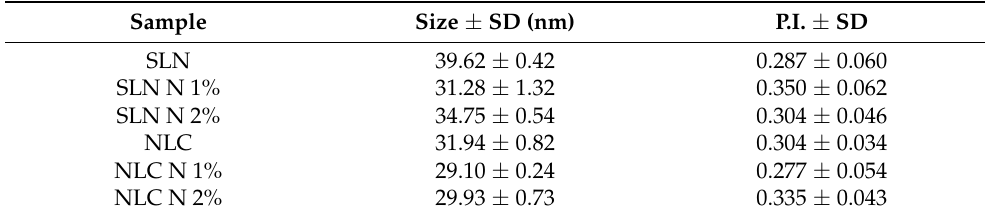
Table 2. The average size and polydispersity index (P.I.) of unloaded SLN, Naringenin-loaded SLN, unloaded NLC, and Naringenin-loaded